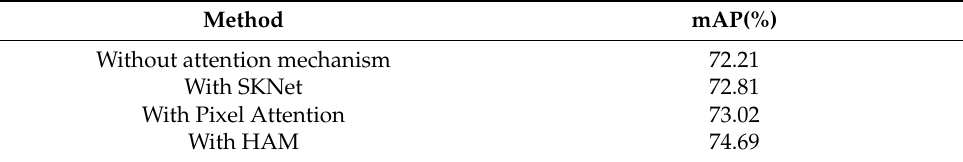
Table 2. Performance comparison of different attention mechanisms.